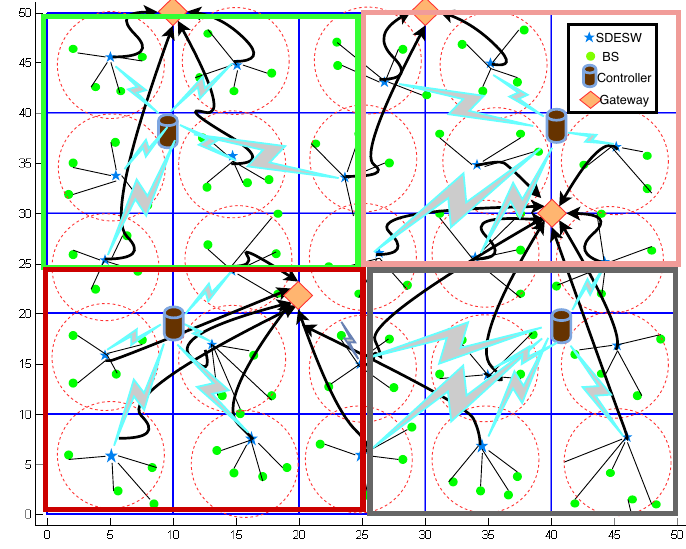
Figure 2. SDWBAN Implementation Scenario (adapted from our previous work Hasan et al.